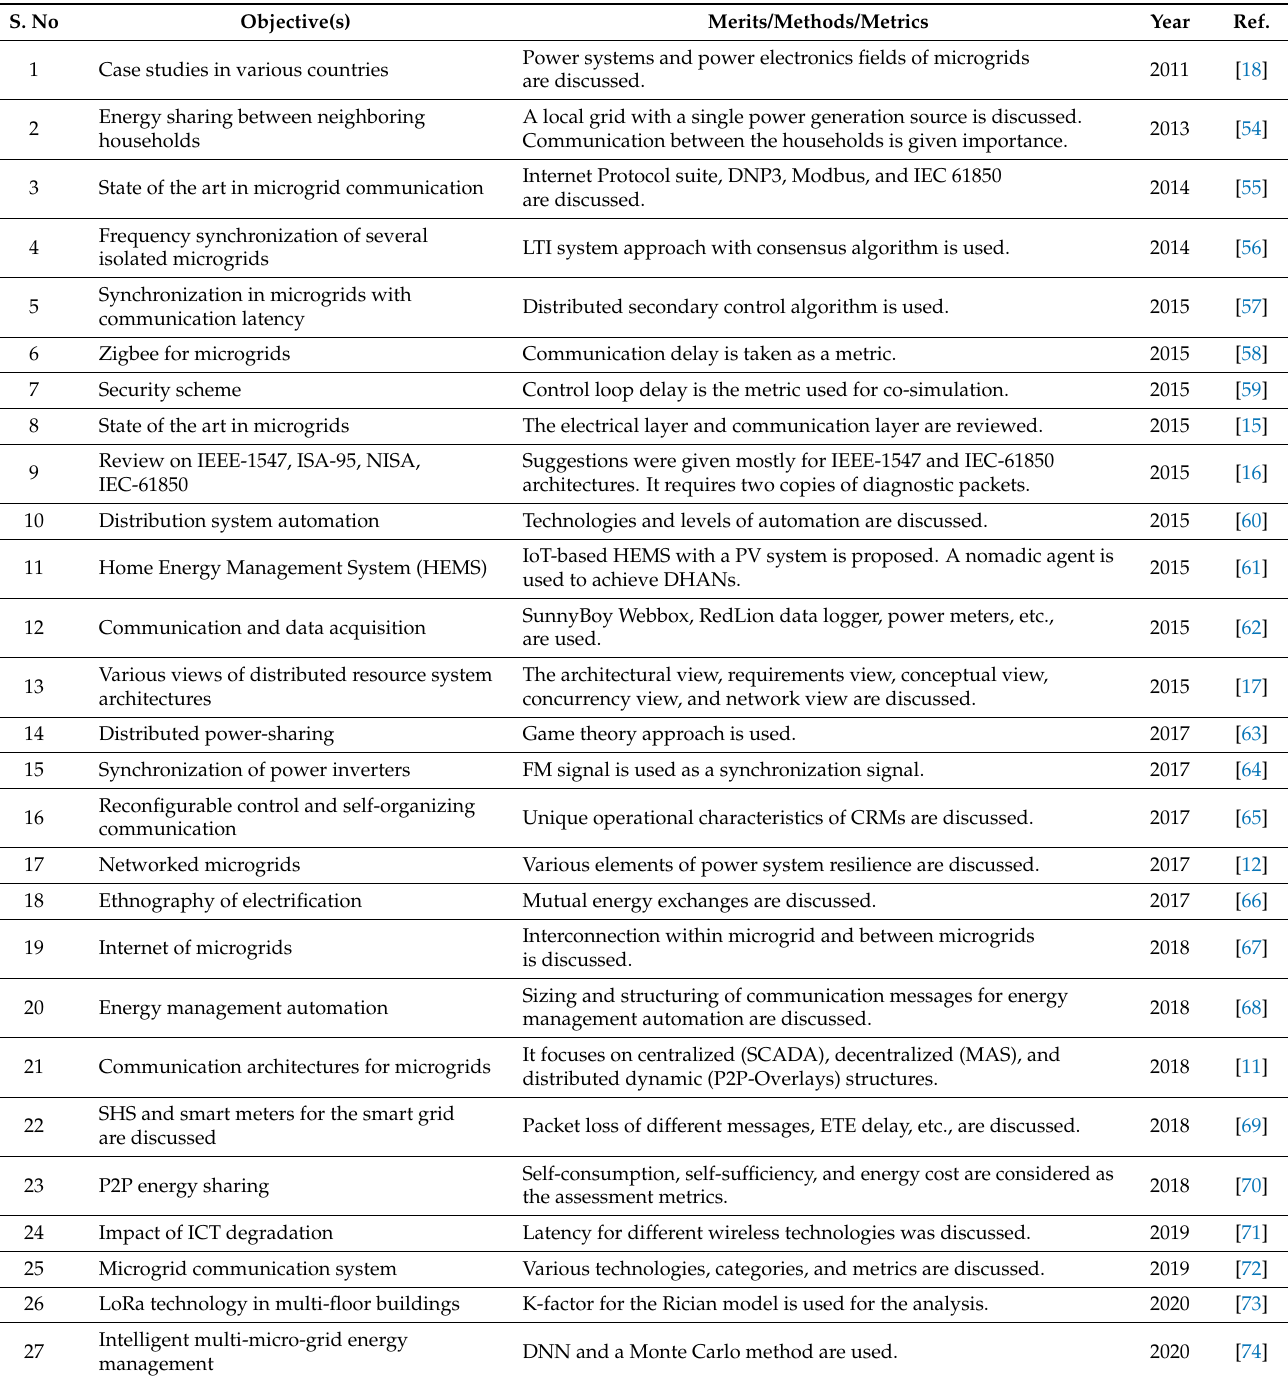
Table 5. State-of-the-art literature works conducted on the